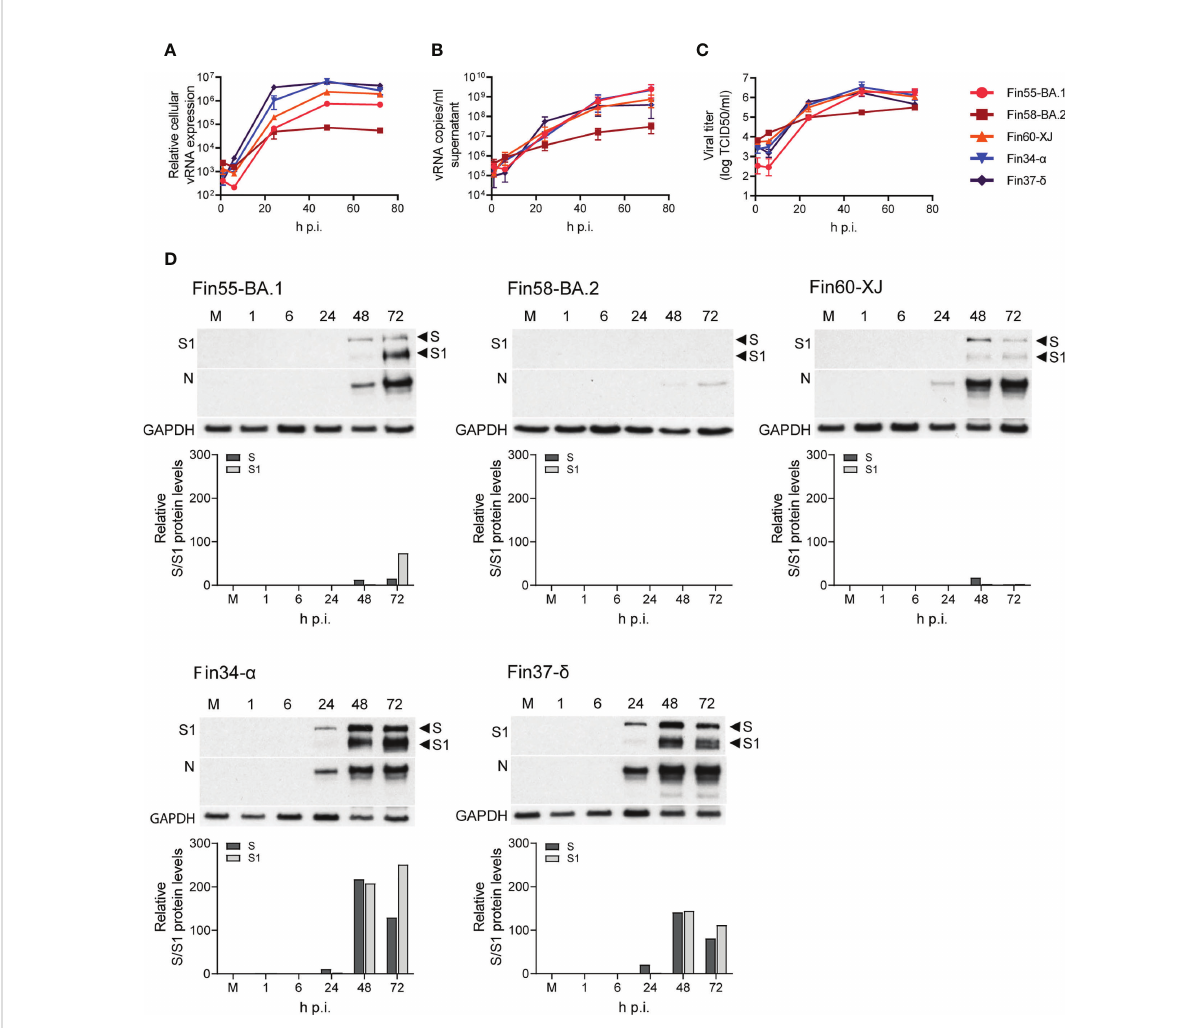
FIGURE 7 Replication of Omicron sublineages BA.1, BA.2 and XJ compared to Alpha and Delta. Calu-3 cells were challenged with three Omicron sublineages and Alpha and Delta variants at multiplicity of 1 for three days and different samples were collected for analysis of the viral molecules. (A) Relative cellular vRNA expression levels determined by RT-qPCR of Fin55-BA.1, Fin58-BA.2 and Fin60-XJ compared to Alpha (Fin34- a ) and Delta (Fin37- d ). (B) Cell culture supernatant vRNA copies/ml were quanti fi ed by RT-qPCR. (C) An end point dilution assay was carried out to determine the production of infectious virions. Results shown as log TCID 50 /ml. (D) Immunoblot analysis of SARS-CoV-2 S protein expression by anti-SARS-CoV-2 S1 fragment antibody (S1) and N protein expression using a cross-reactive anti-SARS-CoV-N protein antibody (N) were carried out once. Full length S protein (S) and the cleaved S1 fragment (S1) are marked with arrows. S protein amounts quanti fi ed using ImageJ are shown in graphs below the immunoblots. GAPDH was used as a loading control. The qPCR and end point dilution assay results are the mean values ± SEM of three independent